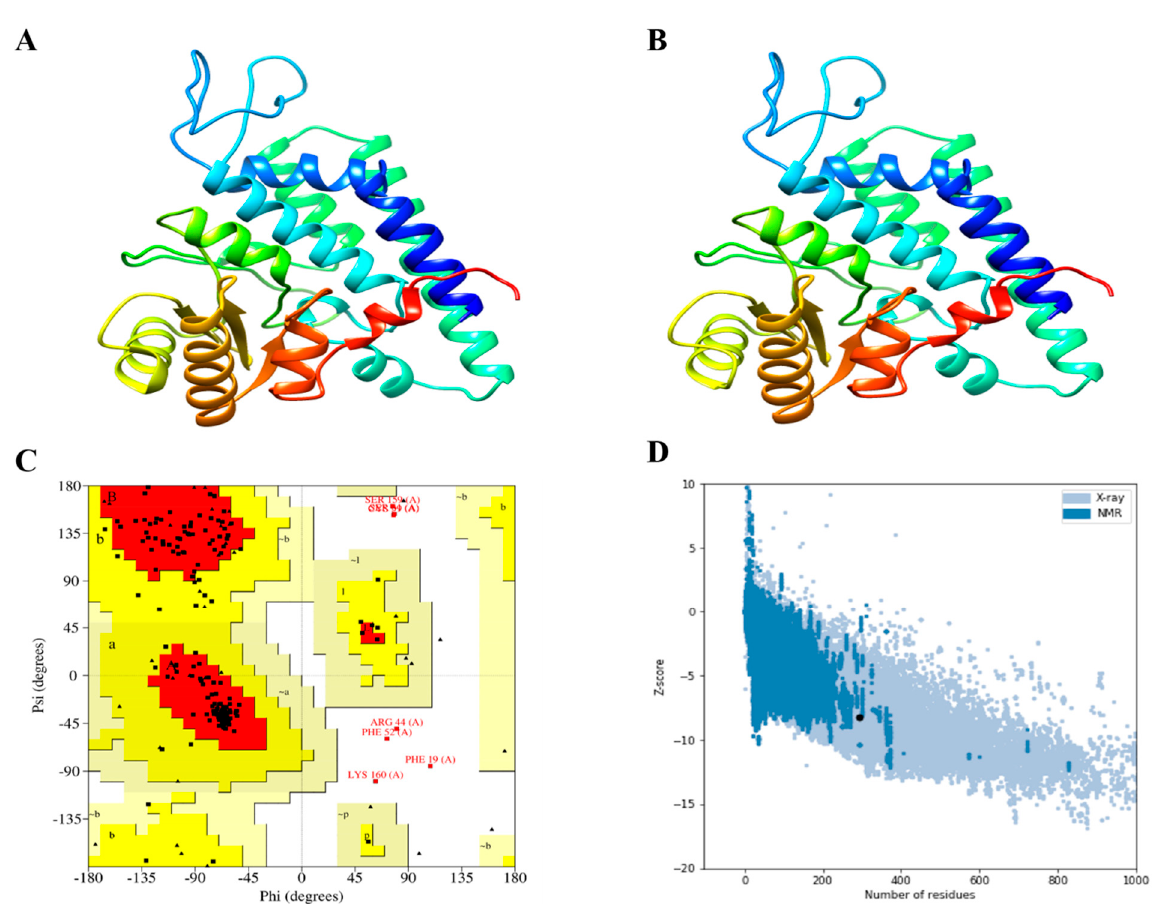
Figure 3. 3D structure modeling, refinement, and quality validation analysis of LSDV-V2. ( A ) The 3D model of predicted vaccine construct ( B ) Refine 3D structure of LSDV-V2 ( C ) The Ramachandran plot analysis of LSDV-V2 shows that 88.2% of the residues are present in the favored region, 8.8% were found in the allowed region, while 2.9% were in the disallowed region of the plot. ( D ) ProSA-web plot for LSDV-V2 model.